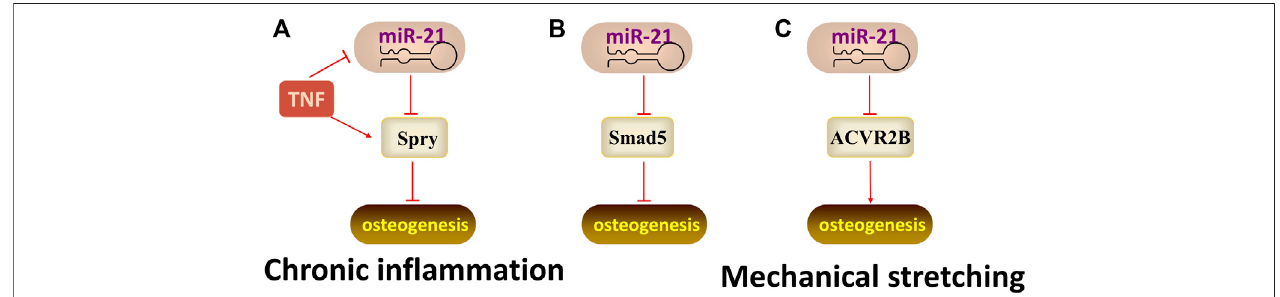
FIGURE 5 | The regulatory mechanism of miR-21. Arrow indicates promotion and T indicates inhibition. (A) MiR-21 inhibits osteogenic differentiation by targeting Spry1 when under the TNF- α -induced in fl ammatory microenvironment. (B) MiR-21 inhibits osteogenic differentiation by targeting Smad5. (C) MiR-21 promotes osteogenic differentiation by targeting ACVR2B when exposed to mechanical